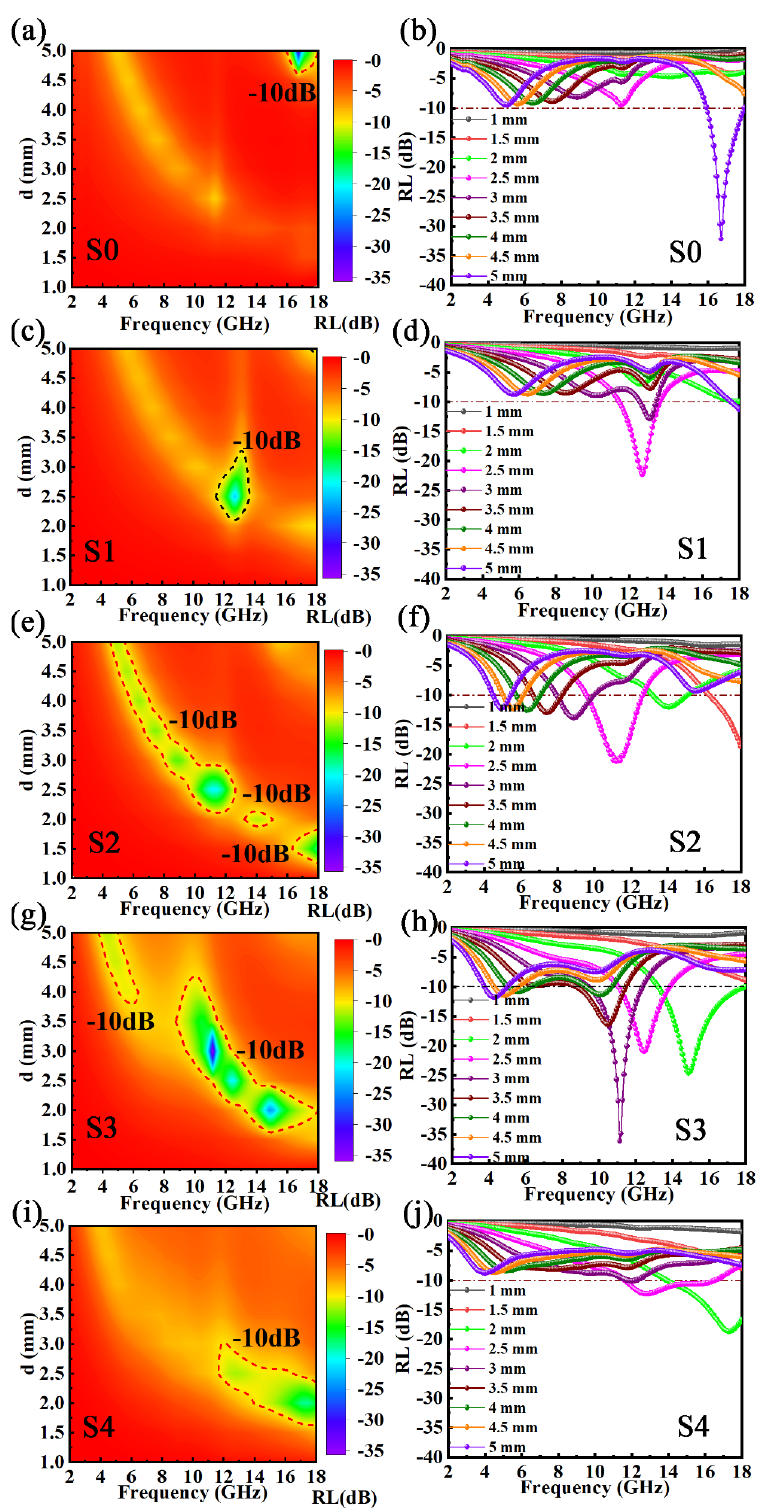
Figure 7. RL contours and RL − 2D curves of the FeSiAl and FeSiAl@HC samples: ( a , b ) S0, ( c , d ) S1, ( e , f ) S2, ( g , h ) S3, and ( i , j ) S4.